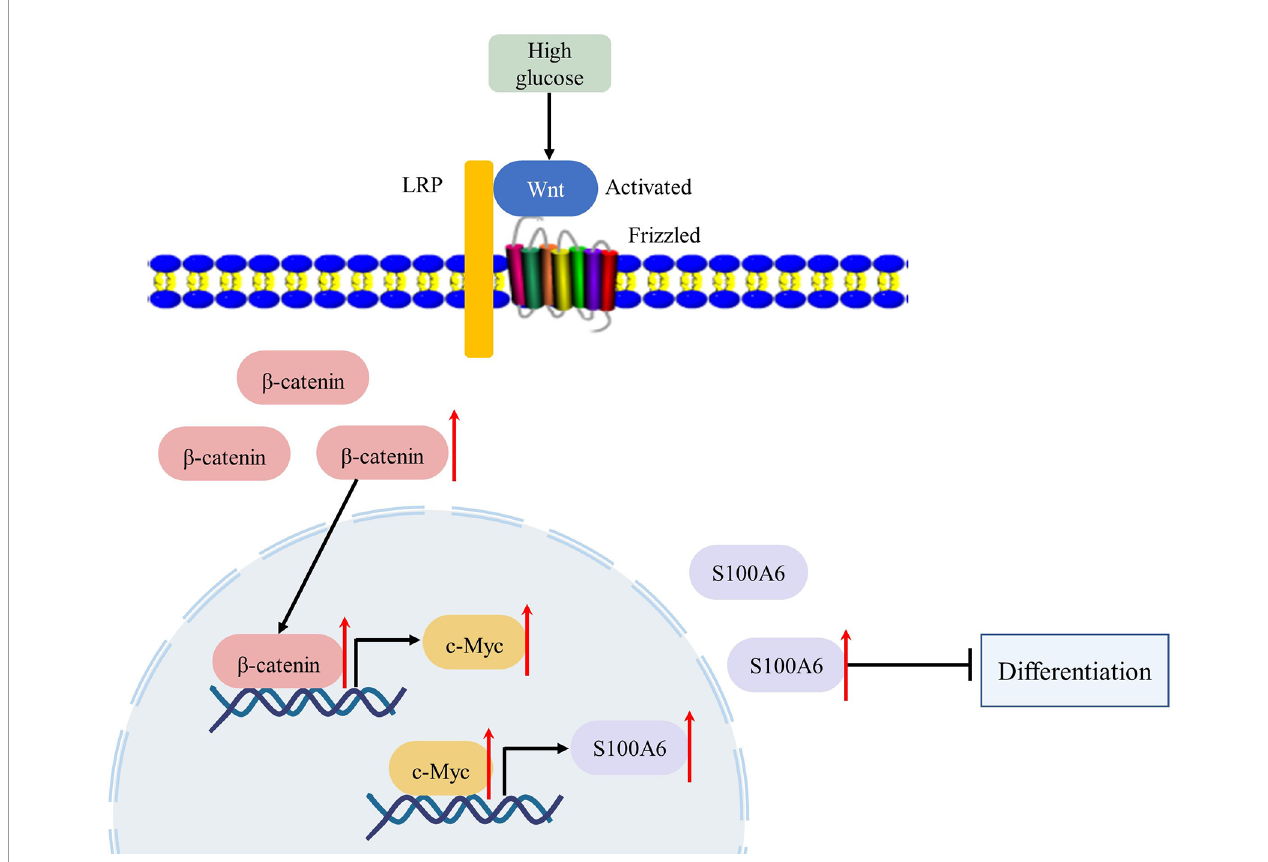
FIGURE 7 | High glucose condition can increase the expression of c-Myc by activating the WNT/ b -catenin pathway, which in turn initiates the transcription of c-Myc target gene S100A6 , causing keratinocyte differentiation